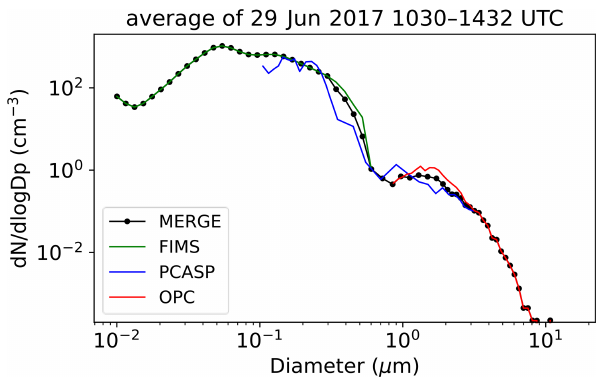
Figure 4. An example of a mean aerosol number distribution merged from the FIMS, PCASP, and OPC instruments for ACE- ENA aircraft measurements on 29 June